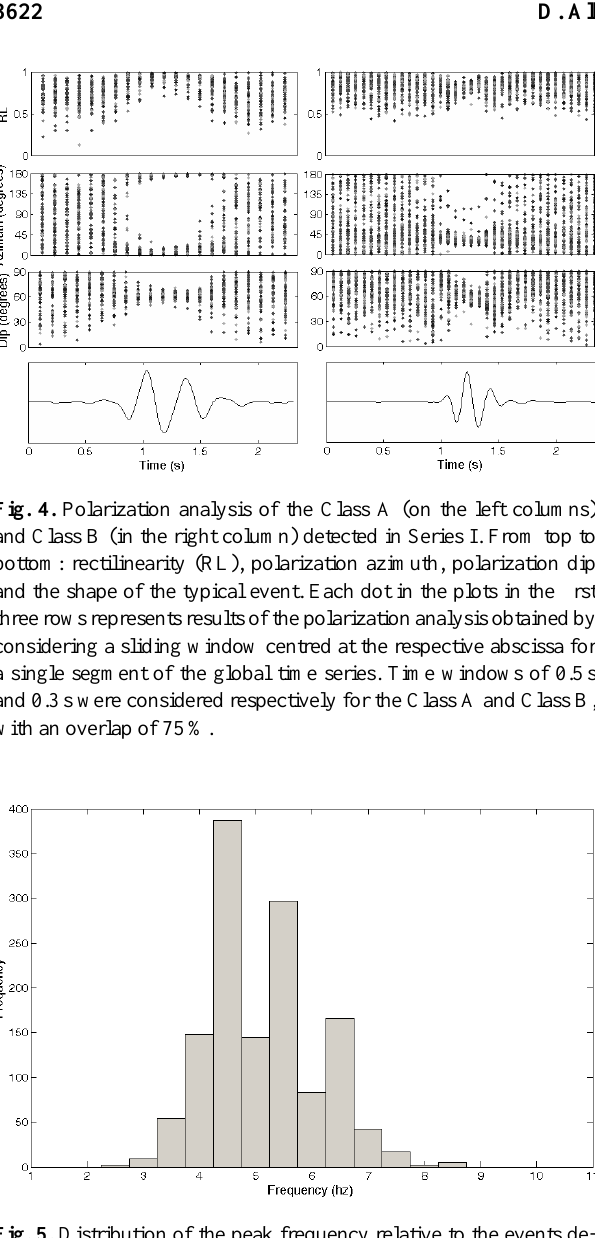
Fig. 5. Distribution of the peak frequency relative to the events de- tected in the Series III after polarization filtering (see the text for details). Three maxima are detected in correspondence with the fre- quencies 4.5Hz, 5.5Hz and 6.5Hz.